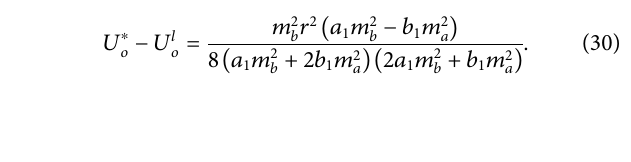
TABLE 3 | Equilibrium values in Scenario II. Parameter Equilibrium